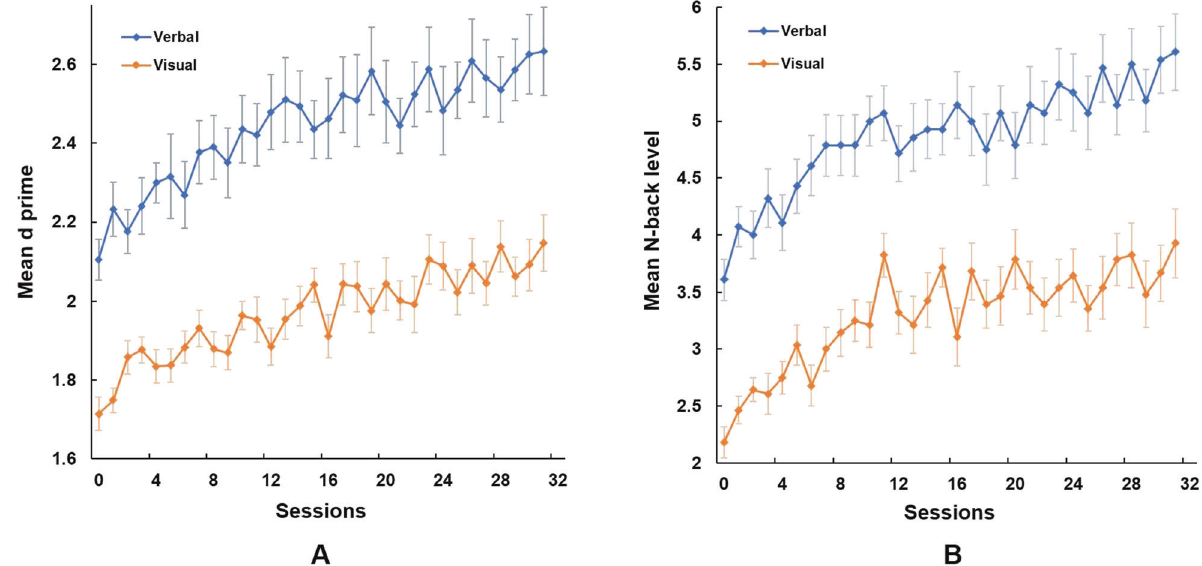
Fig. 3 Training results for the experimental group. A d prime mean values per session, B n -back level mean values per session; data are shown as mean ±